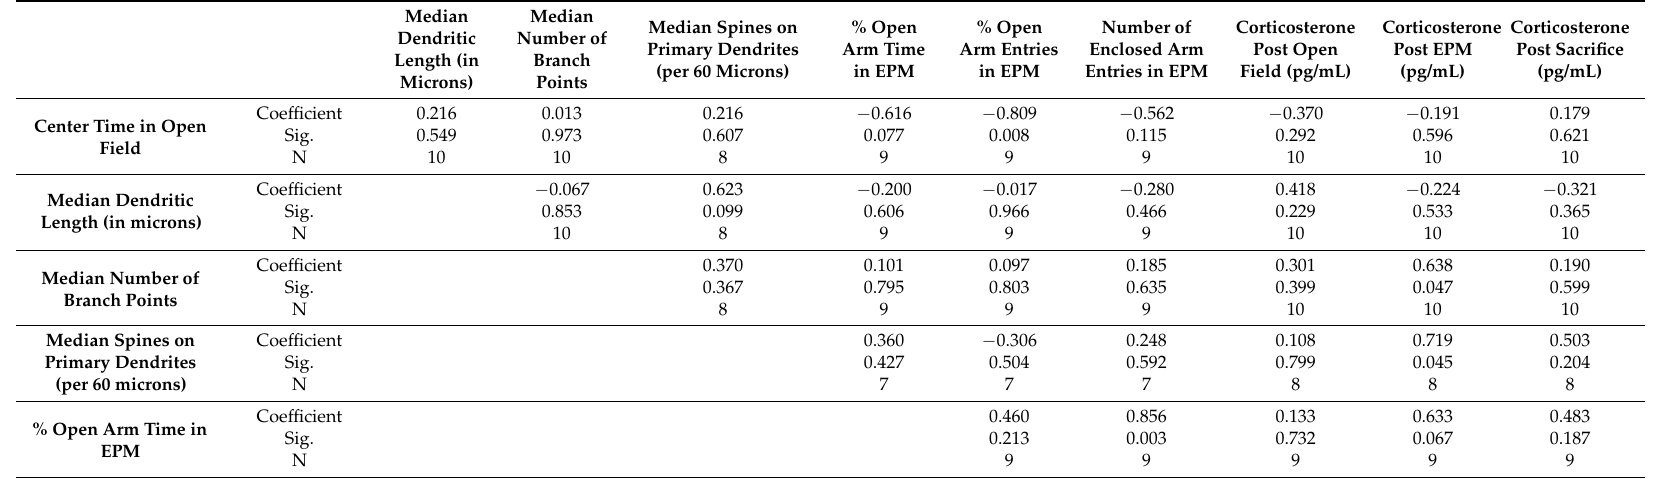
Table 2. Spearman’s rank correlation coefficients for endpoint pairs. The number of animals and p values are also listed. Shaded cells depict endpoint pairs with statistically significant